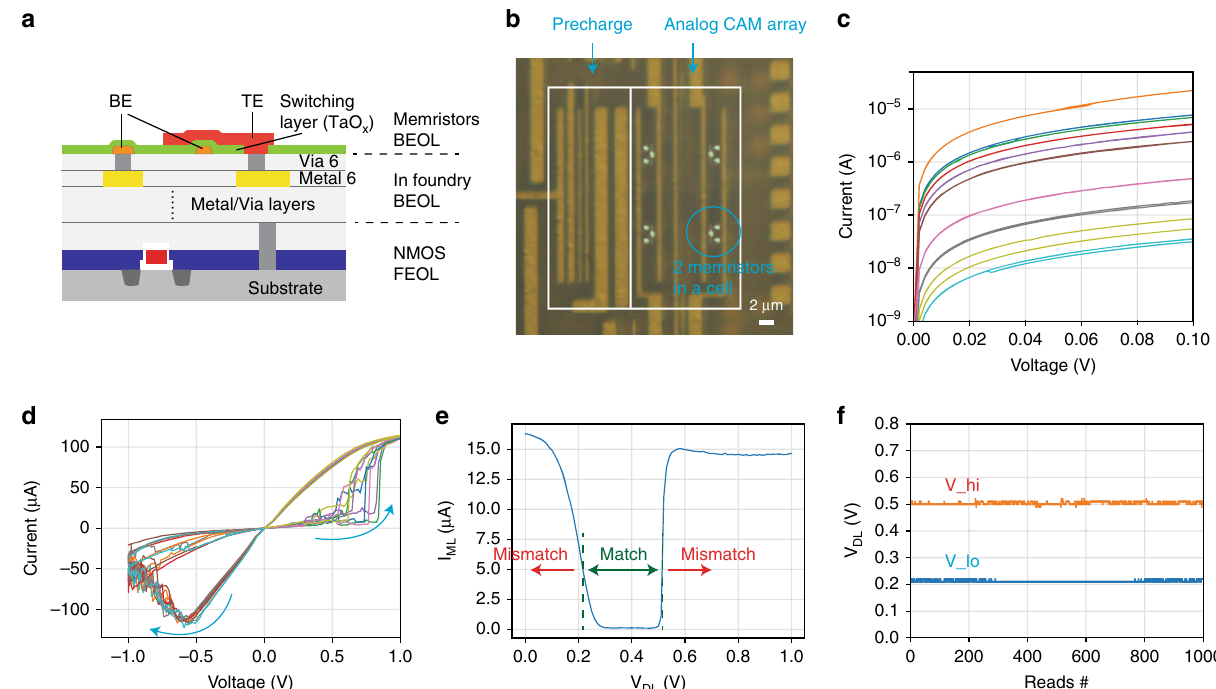
Fig. 4 Experimental demonstration. a Cross-sectional diagram showing monolithic integration of memristor on top of CMOS circuits. b An optical microscope image of an integrated analog CAM array with an on-chip precharging peripheral circuit. c Current – voltage relation of the memristor in the analog CAM circuit for many programmed states, showing the wide continuously tunable conductance range. d The conductance can be programmed from a low conductance state to a high conductance state by a large voltage (>0.5 V) on SL_hi, and reversed by a large voltage on SL_lo. e The Match Line (ML) pull-down current with respect to the applied data line voltage, after programming the memristors. f The analog CAM cell stored range was extracted from the pull-down current in Supplementary Fig. 6 (and one trace in ( e )) where a high pull-down current (> 5 μ A) indicates a mismatch. The range stayed unchanged for 1000 searches over more than 8000